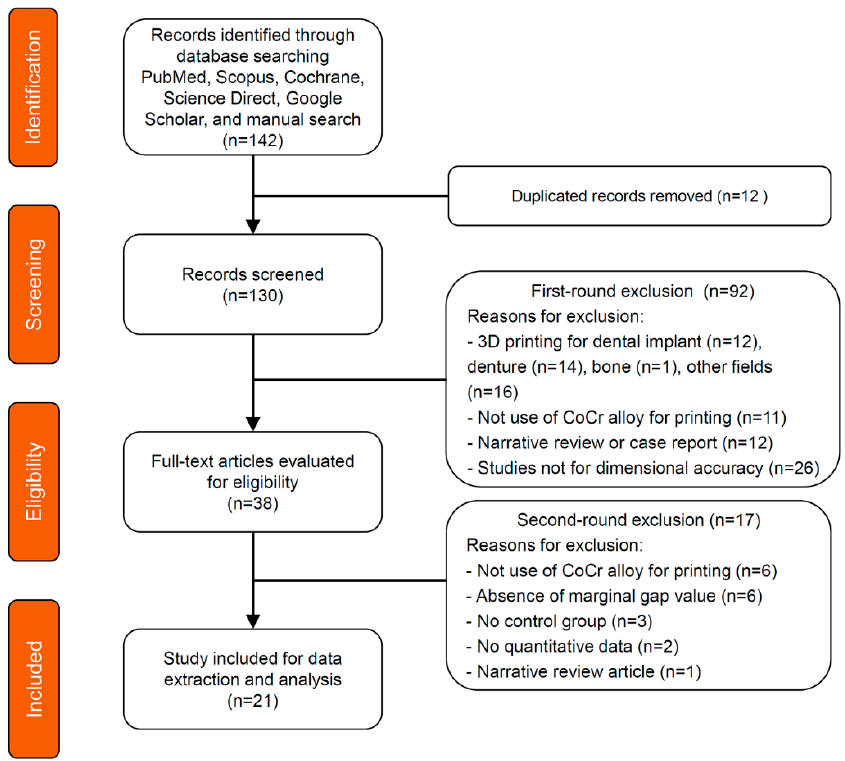
Figure 1. PRISMA flow diagram of the literature search. Table 2. Characteristics of the included studies (n =